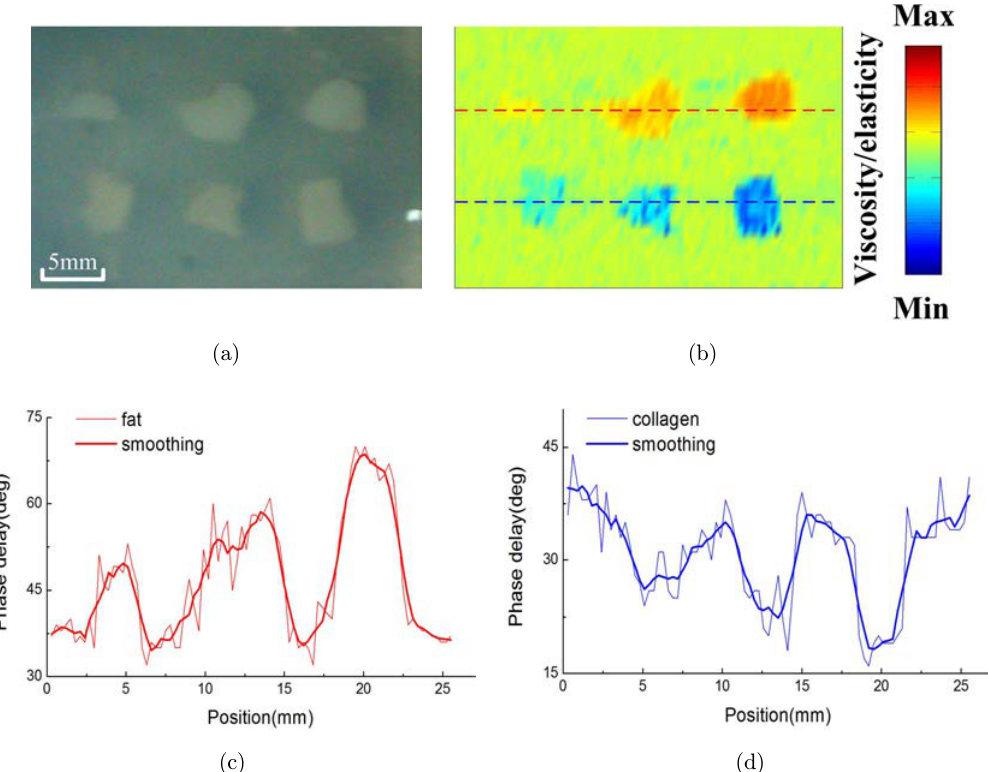
Fig. 4. (a) Photograph of the phantoms prepared by mixing gelatin with fat and collegen at di®erent concentrations. (b) The PAVEI of gelatin phantoms. (c) and (d) Reconstruction pro¯les of PAVEI image at the position indicated by red and blue